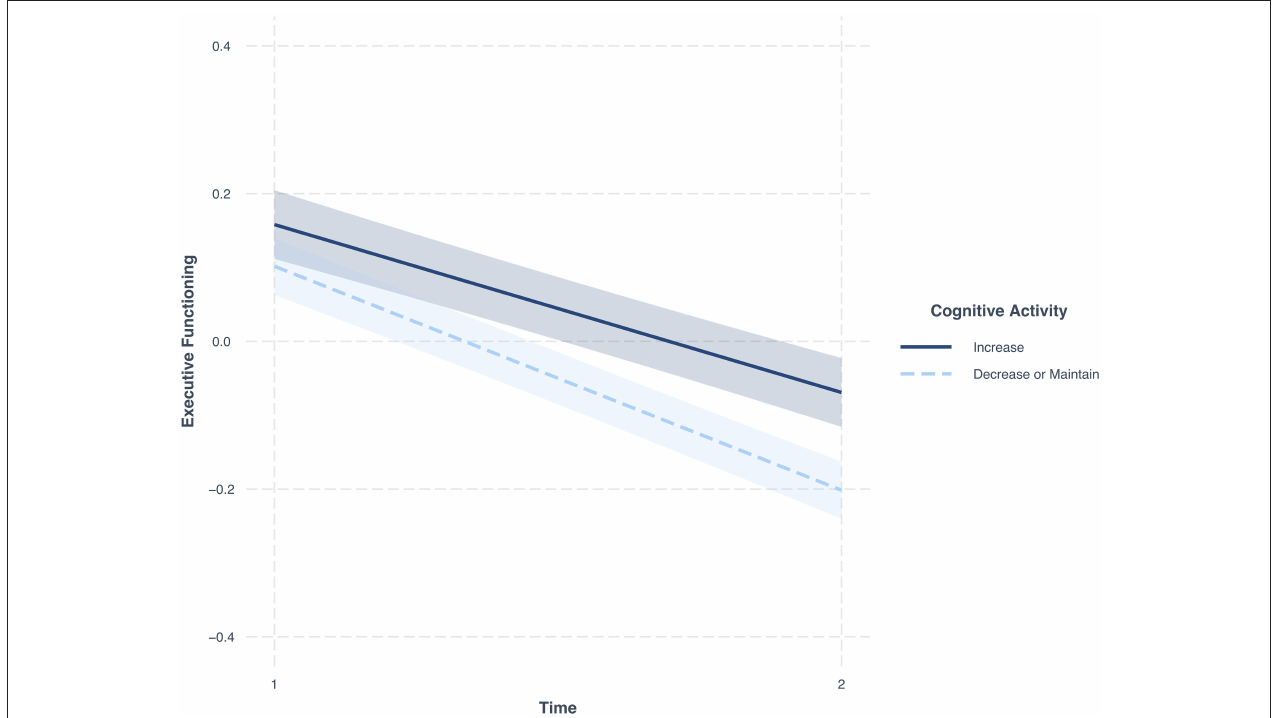
FIGURE 1 | Changes in EF over time. Dark blue, change in individuals who increased their cognitive activity across the 9 years; Light blue, change in individuals who decreased or maintained their cognitive activity across the 9 years; Figure includes 95 percent confidence intervals; Covariates in model, cognitive activity at M2, income, age, sex, frequency of physical activity, functional health, self-rated health, BMI, depression, diabetes, head trauma, hypertension, smoking, sleep problems, vitamin C, alcohol or drug.